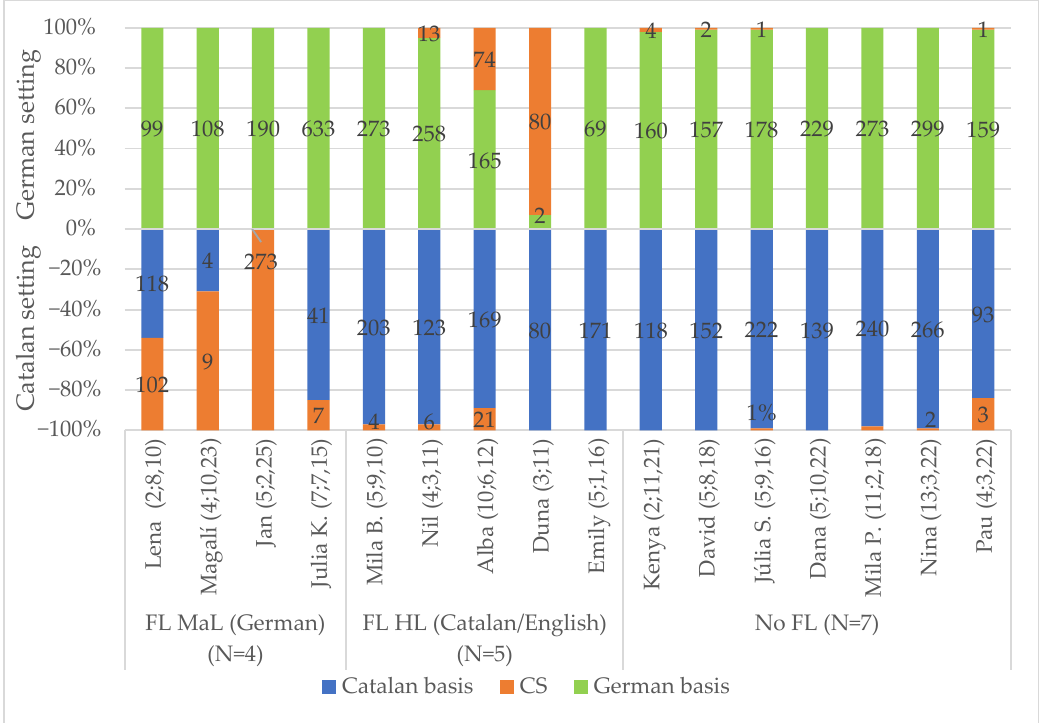
Figure 14. German and Catalan basis and CS according to the child’s FL.